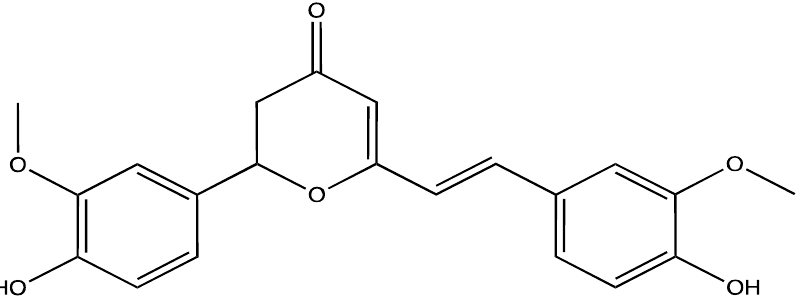
Figure 13. Structure of cyclocurcumin, an active constituent of C. Longa ethanolic extract. Shear-stress describes the force applied by blood flow within blood vessels which increases in blocked vessels due to thrombosis [131]. In addition, the effects of 25 µ M of nine active constituents isolated from C. longa ethanolic extract: artumerone, bisabolatraen, bisacurone, bisdemethoxycurcumin, curcumin, 4-dehydroxybisacurone, demethoxycur- cumin, β -hydroxycinnamic acid and β -sitosterol were examined (Table 6). Although these compounds reduced aggregation to different extents, they were insignificant compared to cyclocurcumin. Moreover, cyclocurcumin showed similar inhibitory effects on aggrega- tion in human isolated platelets. Cyclocurcumin (1,5 and 10 µ M) also markedly reduced intracellular Ca +2 levels, serotonin release, dense and α - granules secretion, fibrinogen and von Willebrand factor (vWF) binding to platelets in shear-stress-induced human isolated platelets (Figure 2) [130]. Table 6. Inhibitory effects of various compounds isolated from C. longa on platelets [130]. SIPA-shear stress induced platelet aggregation. Isolated Compounds ( µ g/mL) (%) Inhibition of SIPA Artumerone 20 Bisabolatraen Bisacurone Bisdemethoxycurcumin Curcumin 4-Dehydroxybisacurone Demethoxycurcumin b-Sitosterol 22 To examine the antiplatelet effects of curcuminoids, Maheswaraiah et al. [132] tested different concentrations of curcumin (10, 30 and 60 µ g/mL) and the curcuminoids rich- ethanolic fraction (10, 20 and 30 µ g/mL) on platelets. The curcuminoids rich fraction consists of 33% curcumin, 18% demethoxycurcumin and 48% bisdemethoxycurcumin and was tested in rat PRP aggregation stimulated by ADP (40 µ M), collagen (15 µ g/mL) and AA (0.75 mM) (Table 7). Generally, all tested concentrations of curcuminoids and cur- cumin showed reductions in aggregation to different levels when three agonists were used, but curcuminoids showed higher inhibitory effects. In addition, 20 µ g/mL of curcumi- noids enhanced the release of nitric oxide in rat platelets upon activation with ADP, AA and